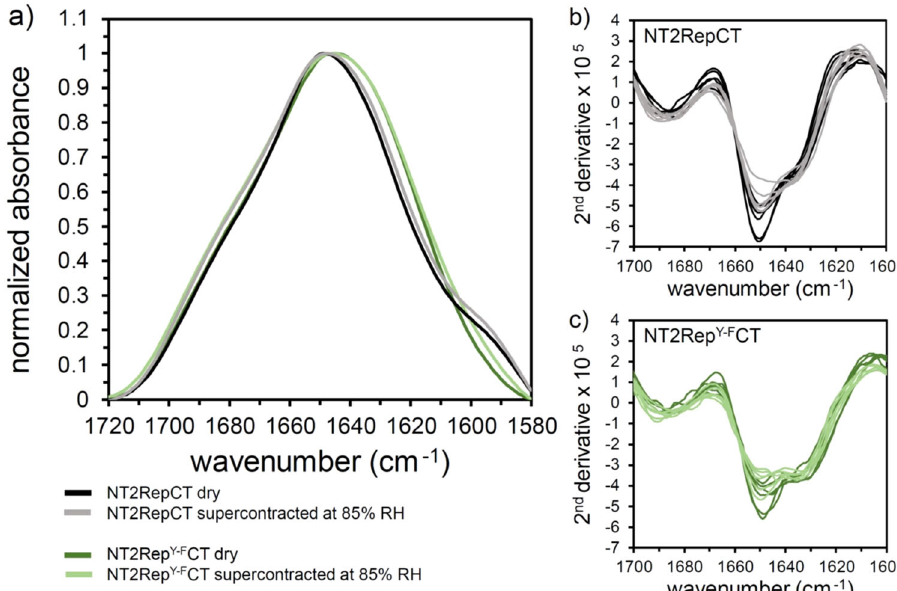
Fig. 6 Secondary structure content analyzed by FTIR spectroscopy. FTIR spectra of NT2RepCT and NT2Rep Y-F CT fi bers, measured on dry as spun fi bers and fi bers that were dried after being supercontracted at 85% relative humidity (RH). a Absorbance in the amide I region (1700 – 1600 cm − 1 ). All spectra represent an average of six measurements, which were baseline subtracted, and normalized. The second derivative of NT2RepCT ( b ) and NT2Rep Y-F CT ( c ), scaled (calculated from the normalized absorbance spectrum and multiplied with a factor 10 5 ) and smoothed (Savitzky − Golay window 19 points), from six individual spectra in the amide I region. Black and gray colors are used for NT2RepCT fi bers and green colors for NT2Rep Y-F CT fi